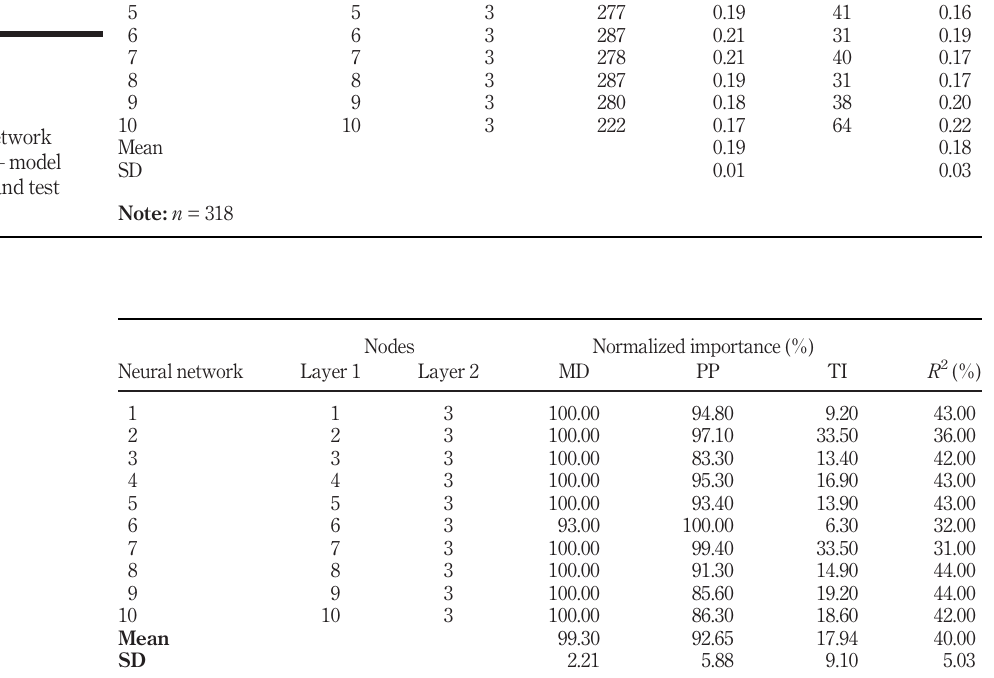
Table 4. Sensitivity